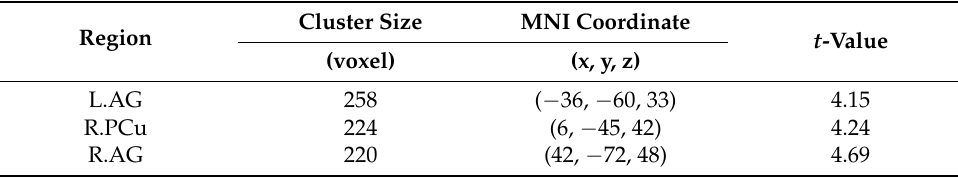
Table 3. Decreased DC in VaMCI compared to HC.